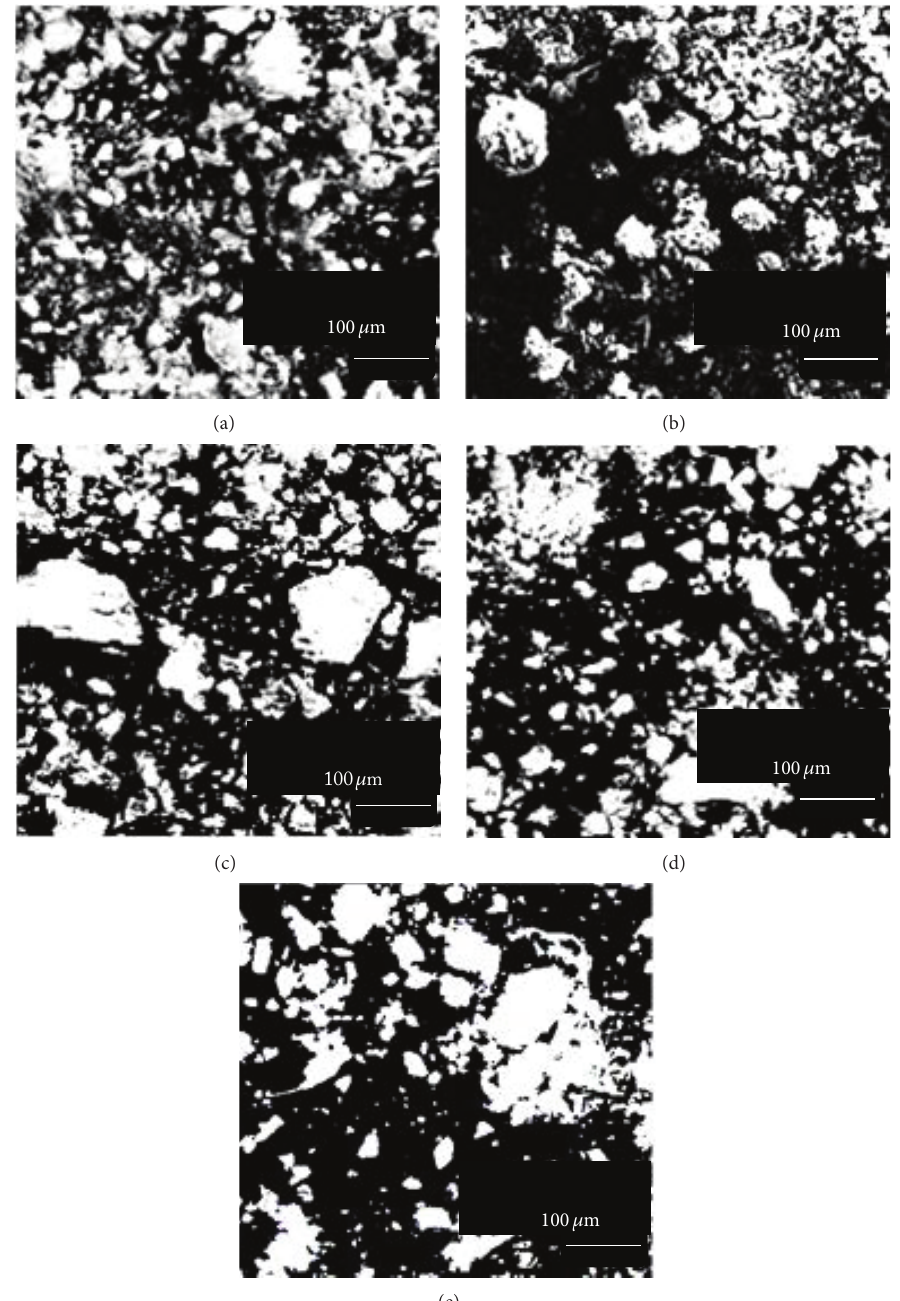
Figure 1: Scanning electron micrographs of two Asian dust particles (ADP1 (a) and ADP2 (b)) and three soil dust (SDP1 (c), SDP2 (d), and SDP3 (e)) samples. Prior to analysis, samples were adjusted to 0.25 mg/mL with deionized water and dried on a hotplate. Scale bars: 100 𝜇 m. 󸀠 󸀠 red-free DMEM containing 20 𝜇 M 2 ,7 -dichlorodihydroflu- orescein diacetate (Cell Biolabs, Inc., San Diego, CA) for 30 min at 37 ∘ C. After incubation, the cells were treated with 100 𝜇 g/mL a suspension of Asian dust particles, soil dust, or DMEM (for negative control) for 6 h and fluorescence was measured at 485 nm (subwave length, 530